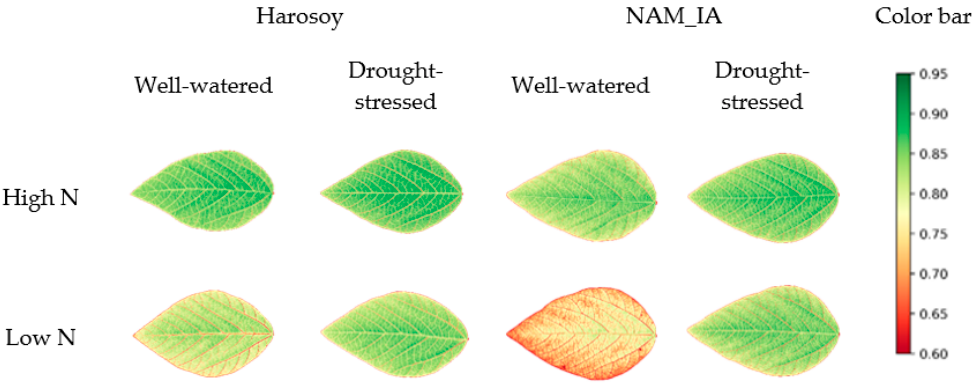
Figure 9. NDVI heatmap images of soybean leaves.